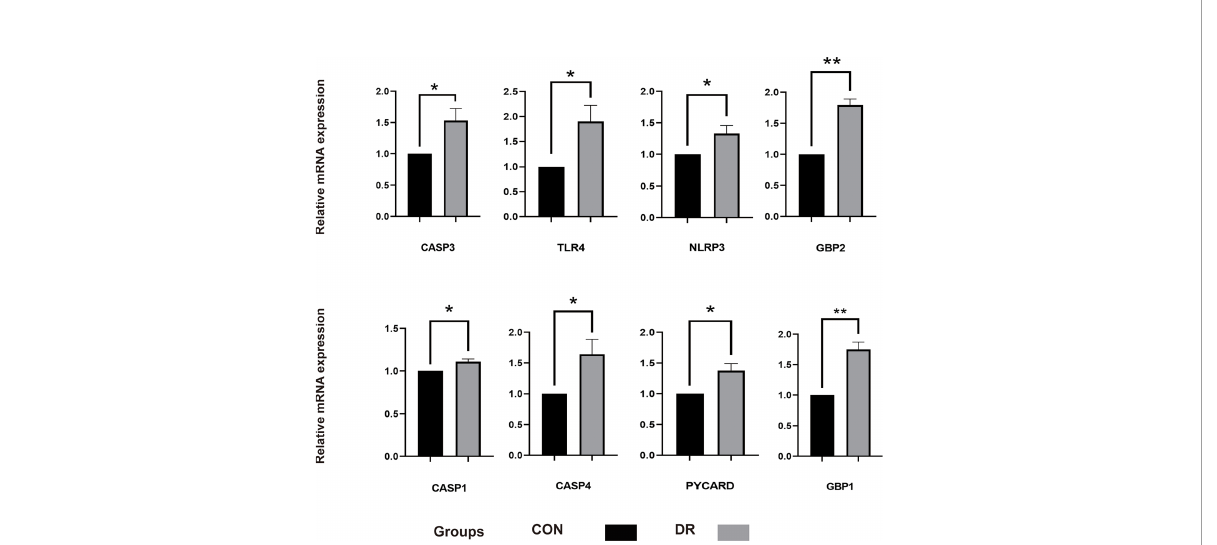
FIGURE 7 qRT-PCR experiment to verify the expression of PRGs of interest in the in vitro model. HRECs exposed to high glucose for 48 h were used as DR model, and HRECs cultured on normal culture medium were used as control. The P -values were calculated using a two-sided unpaired